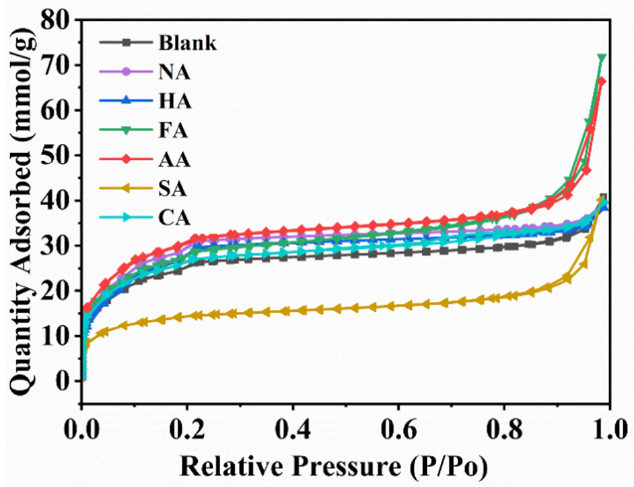
Figure 4. Nitrogen adsorption–desorption isotherms of the blank sample and MIL-101 (Cr, Sn) synthesized with different modulators.